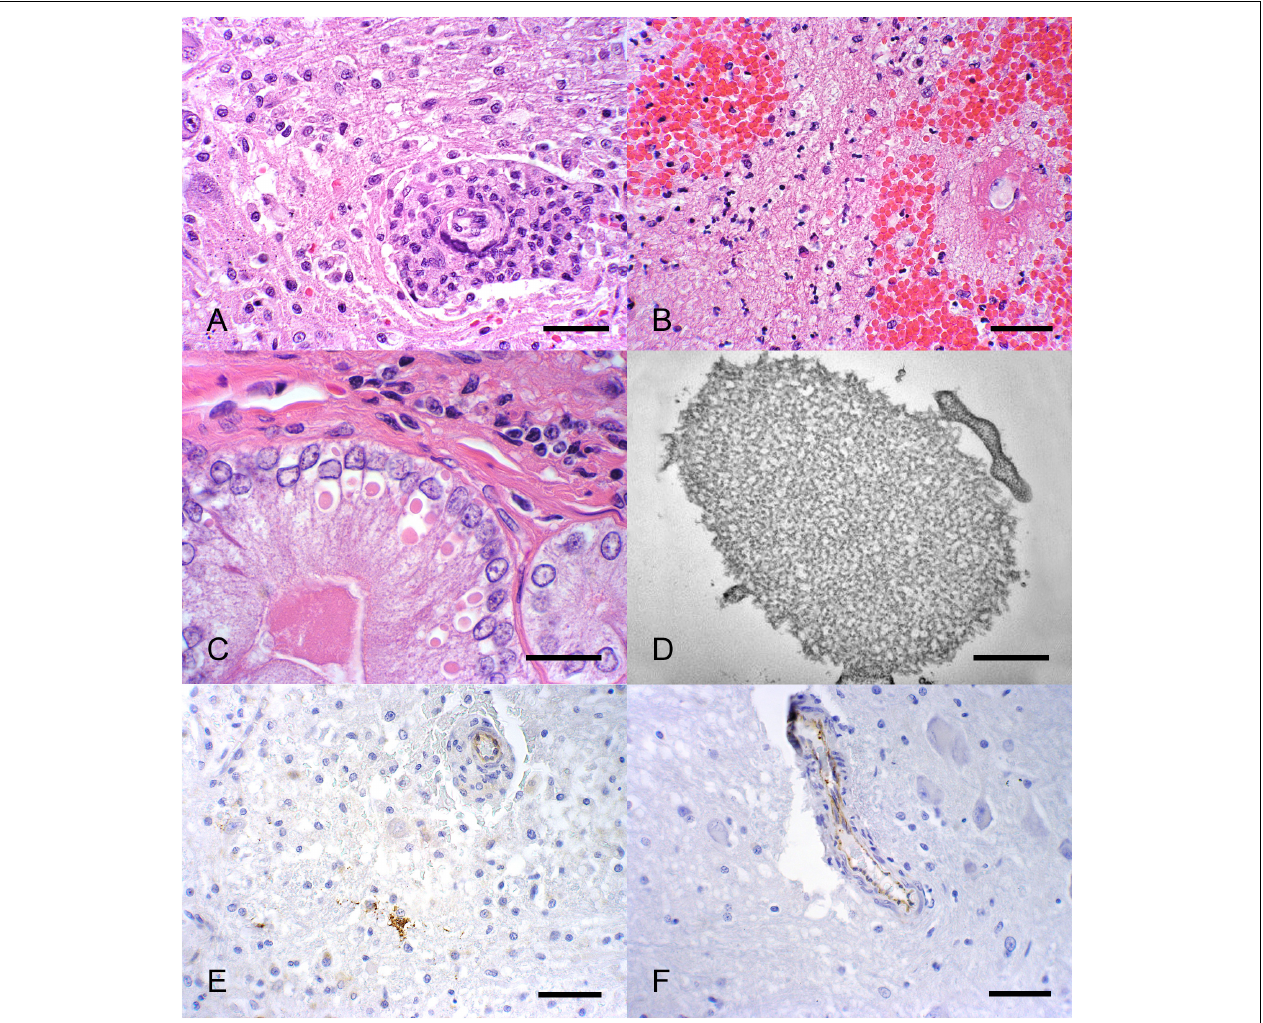
FIGURE 5 | (A) Encephalitis characterized by perivascular lymphohistiocytic in a phocine distemper virus-positive sea otter (magnification 400 × ; scale bar = 40 µ m). (B) Focal, perivascular, suppurative encephalitis with endarteritis and fibrinoid necrosis (magnification 400 × ; scale bar = 40 µ m). (C) Eosinophilic intracytoplasmic inclusion bodies present in biliary and pancreatic epithelial cells (magnification 400 × ; scale bar = 40 µ m). (D) Electron microscopy of pancreatic cells with viral structures consistent with a paramyxovirus infection (magnification 46460 × ; scale bar = 500 nm). (E) Immunohistochemistry for morbillivirus highlighted rare neurons (F) and endothelial cells as positive (magnification 400 × ; scale bar = 40 µ m).